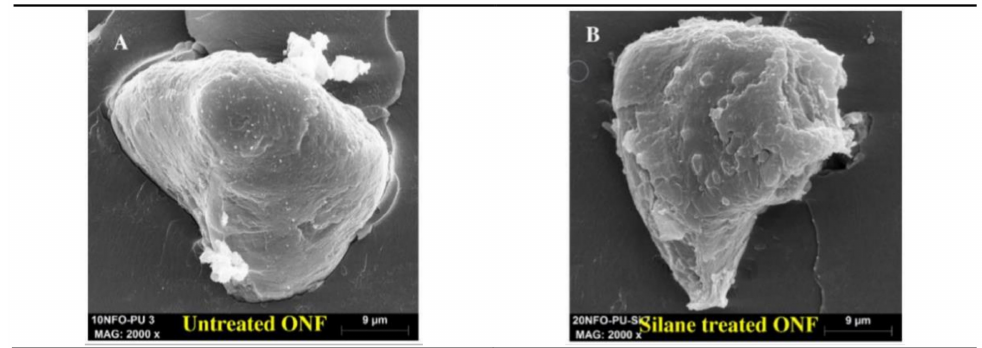
Figure 11. SEM micrograph: ( A ) In the absence; ( B ) in existence of treatment